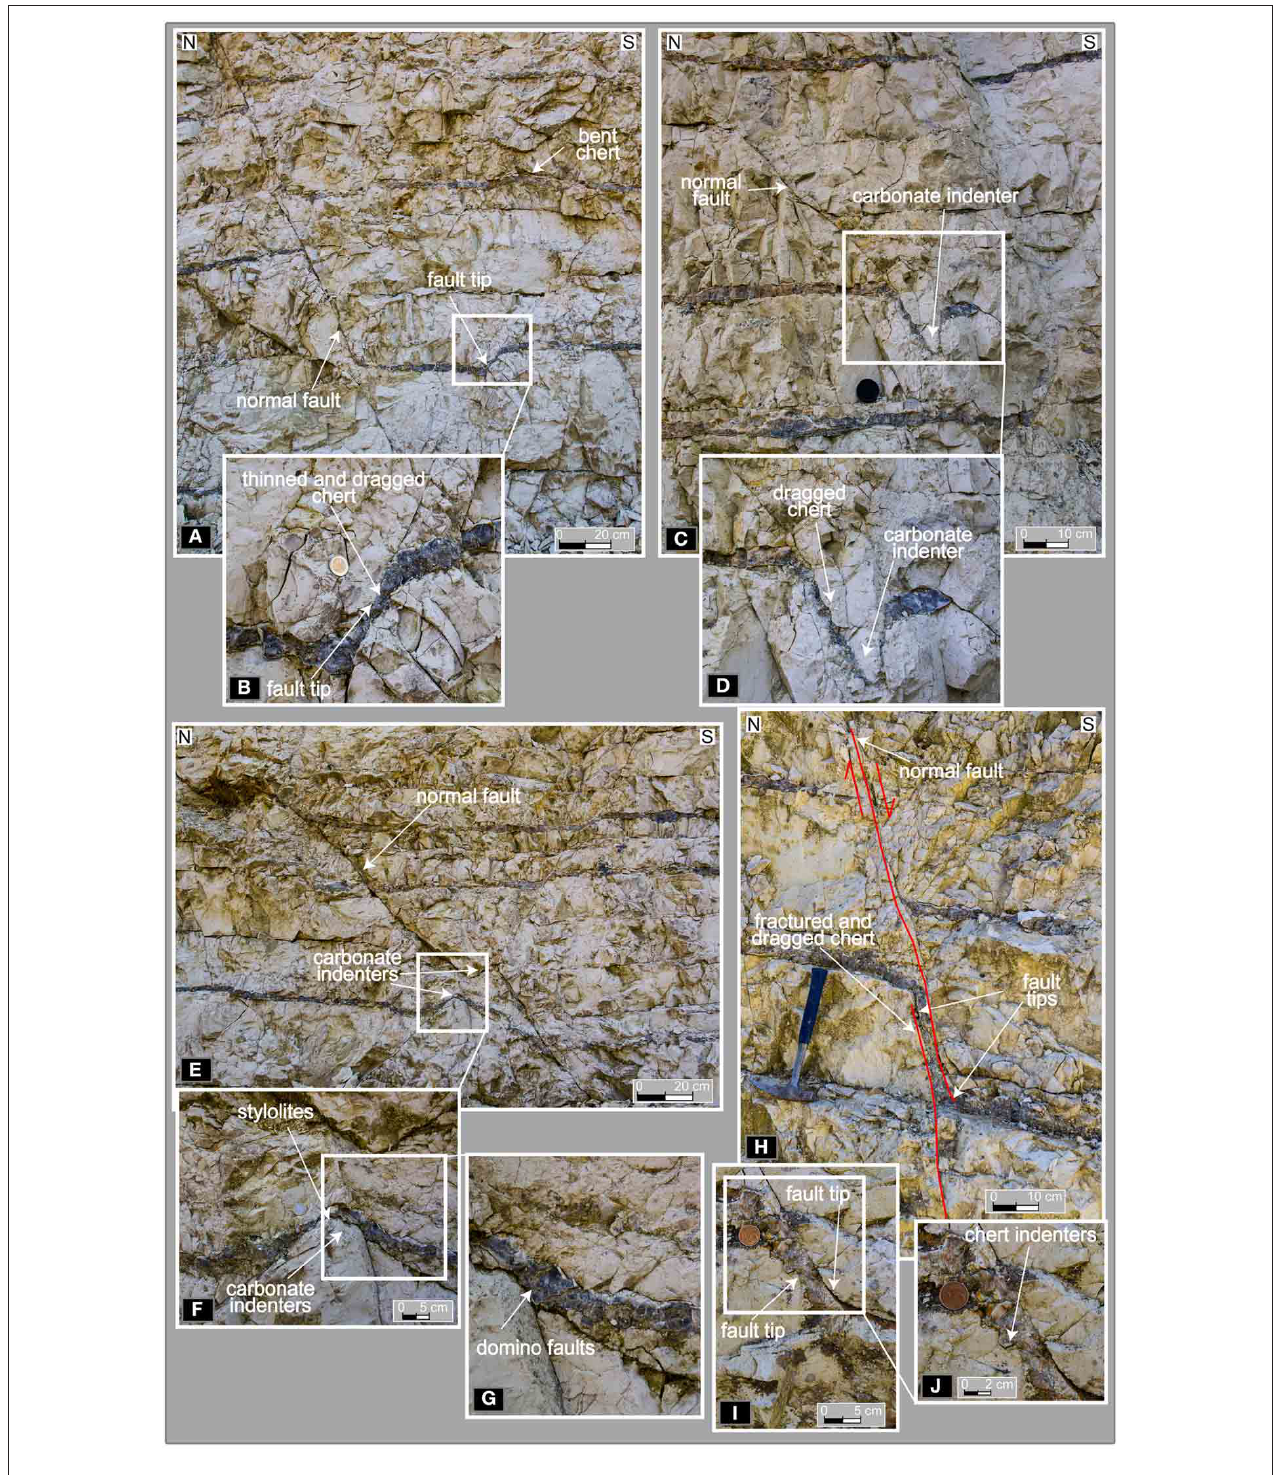
FIGURE 6 | Exposure photographs (Scaglia Bianca Fm.). (A) Normal faults across alternate carbonate-chert beds. (B) Enlargement from the previous photograph. Note that the faults abut against the chert layer that is dragged downdip along the fault surface. (C) Normal faults across alternate carbonate-chert beds. (D) Enlargement from the previous photograph. (E) Normal faults across carbonate-chert beds. (F) Enlargement from the previous photograph. Note the stylolitic profile of the chert-carbonate lower interface. (G) Enlargement from the previous photograph. Note the small domino faults and other brittle deformation affecting the chert layer. (H) Normal faults across alternate carbonate-chert beds. (I) Close-up photograph from the studied outcrop. Note that the faults terminate against the chert layer that is bent and dragged consistently with the normal fault offset. (J) Enlargement from the previous photograph. Note that the downward chert indenters into the lower carbonate bed are not vertical, but seemingly rotated about a horizontal axis by about 45 ◦ consistently with the normal fault offset.